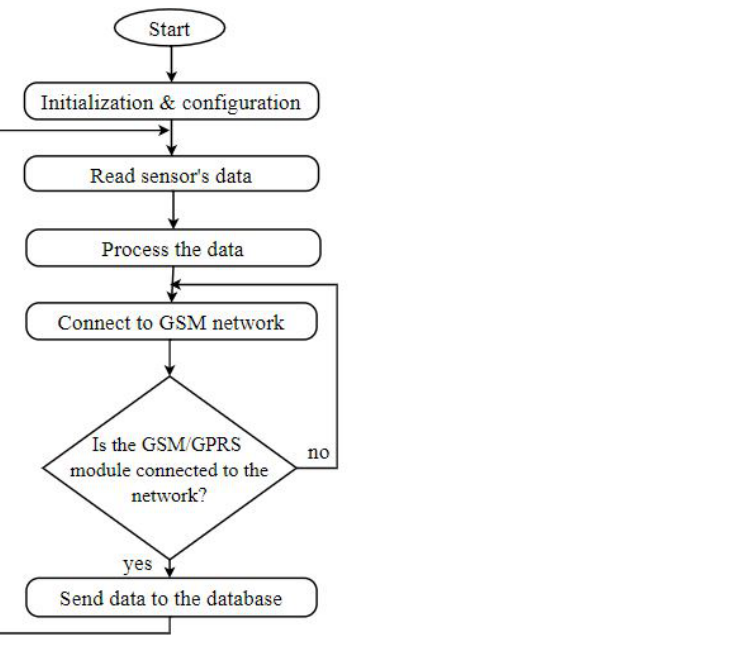
Figure 6. A program running into Arduino Uno.